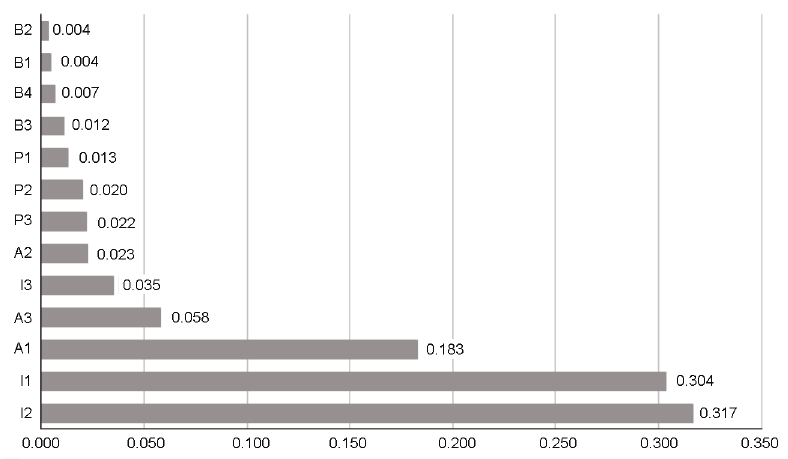
Figure 3. Priority of the factors influencing initial trust for consultants